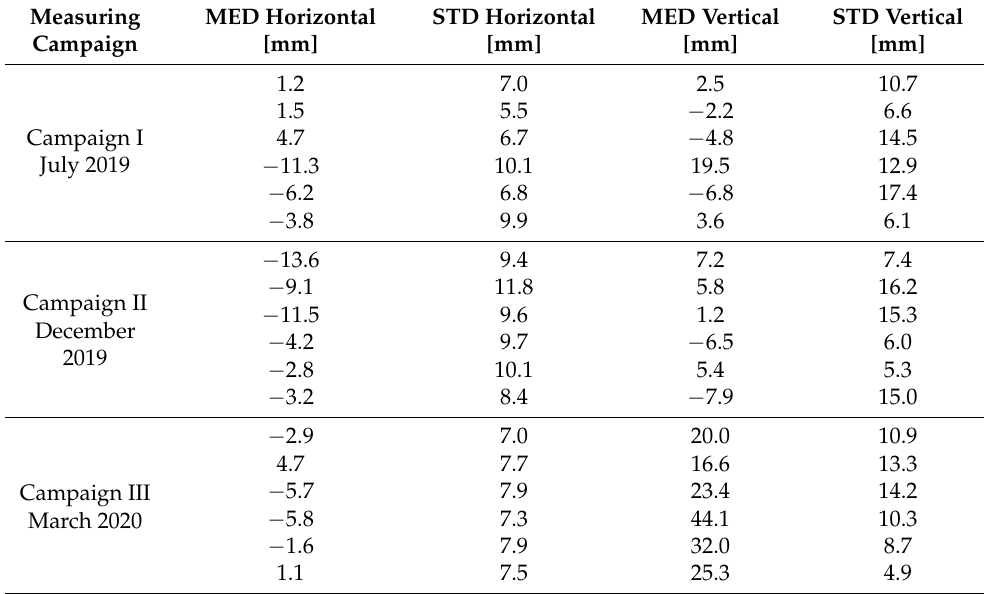
Table 1. Statistical values describing the reconstructed measurement signal. Measuring